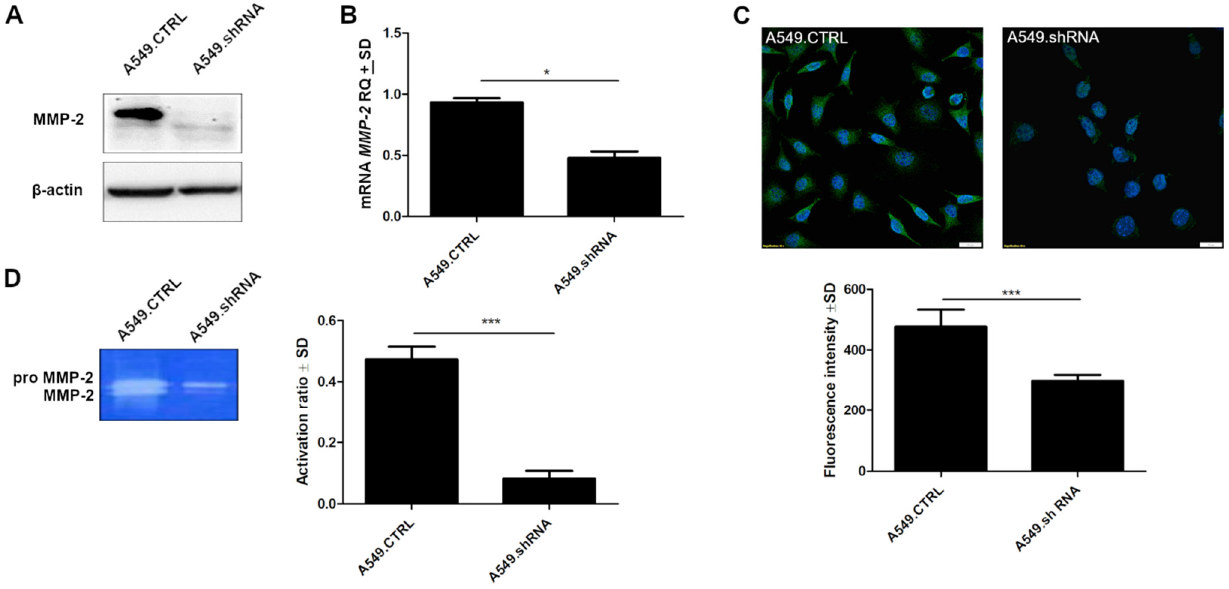
Figure 12. Effects of periostin (POSTN) silencing on MMP-2 expression and MMP-2 activity. ( A ) MMP-2 protein was detected by Western blot analysis. β -actin served as an internal control. Western blotting shows marked changes in the expression level of MMP-2 in control (A549.CTRL) cells and A549.shRNA cells transfected with POSTN-specific short hairpin. ( B ) Relative quantification (RQ) of mRNA expression levels of MMP-2 mRNA in control cells (A459.CTRL) and A549.shRNA cells (* p < 0.05). ( C ) Comparison of MMP-2 expression levels detected by confocal microscopy in control A549.CTRL cells and in the cells representing the loss-of-function phenotype (A549.shRNA) (*** p < 0.001). Objective 60 × /1.40 Oil; pinhole airy 1.25. Bar = 20 µ m. ( D ) MMP-2 activity was analysed using gelatin zymography (*** p < 0.001). RQ, relative quantification.